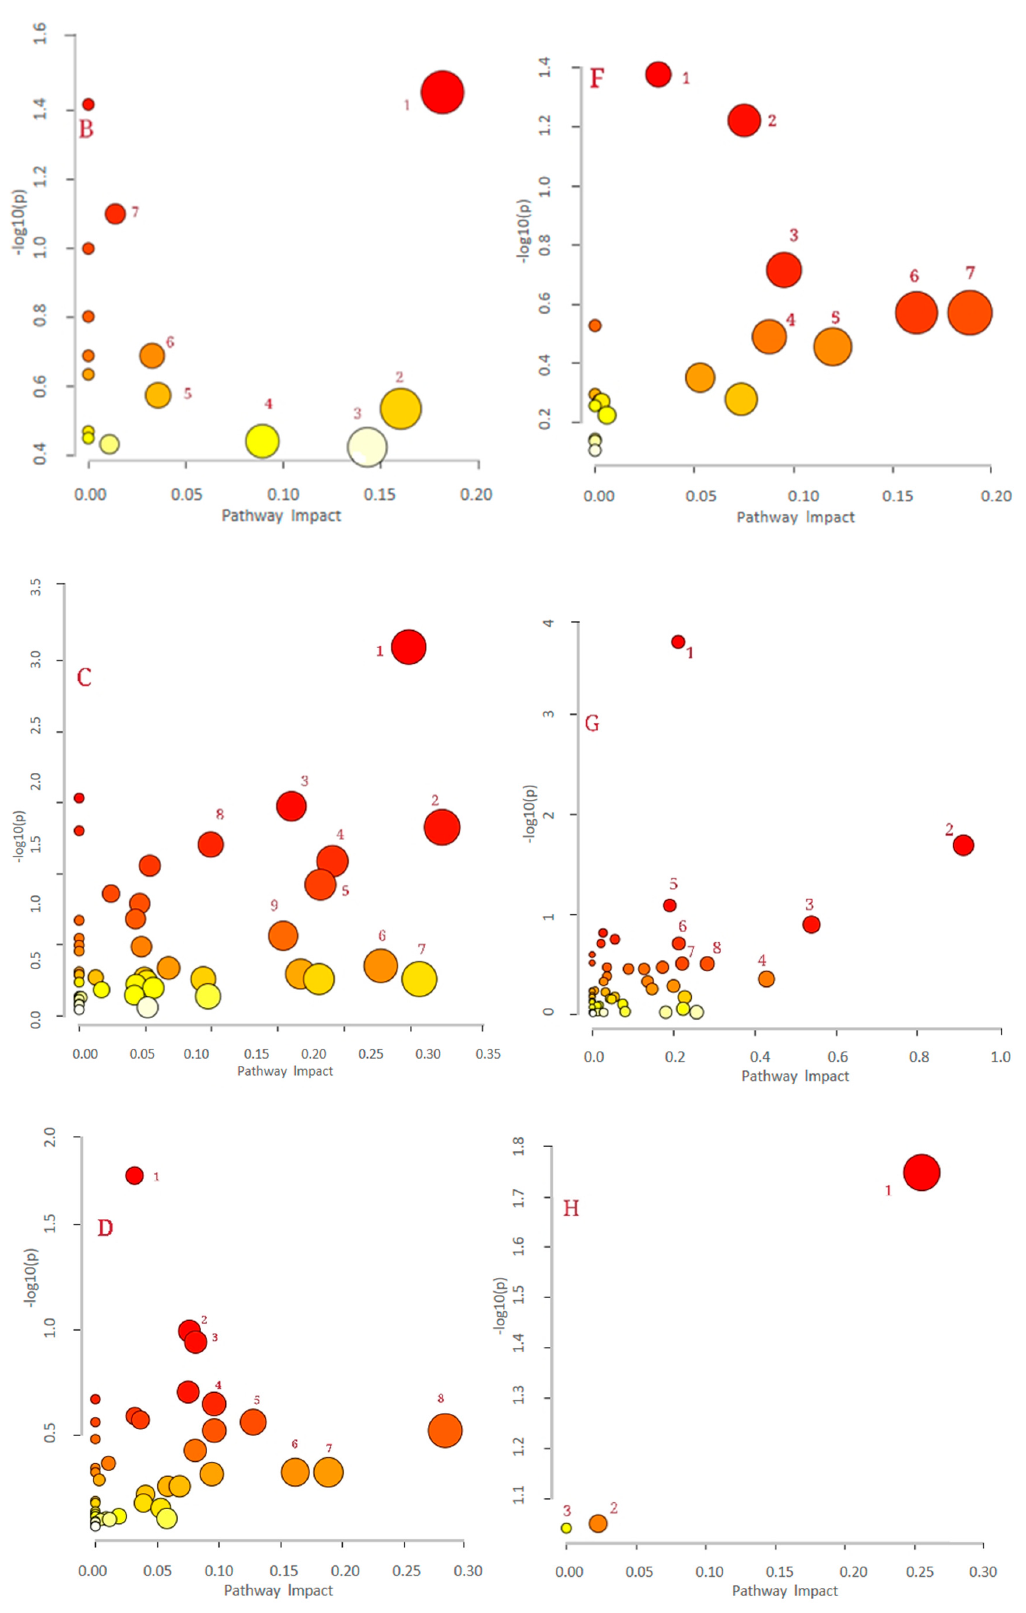
Figure 4. Enrichment maps of upregulated metabolic pathways in negative and positive modes. Negative ion mode: ( A ) LPS vs. QF 0.1; ( B ) LPS vs. QF 1; ( C ) LPS vs. QF 10; ( H ) Control vs. LPS.Positive ion mode: ( D ) LPS vs. QF 0.1; ( E ) LPS vs. QF 1; ( F ) LPS vs. QF 10; ( G ) Control vs. LPS. Data point descriptions are in Table